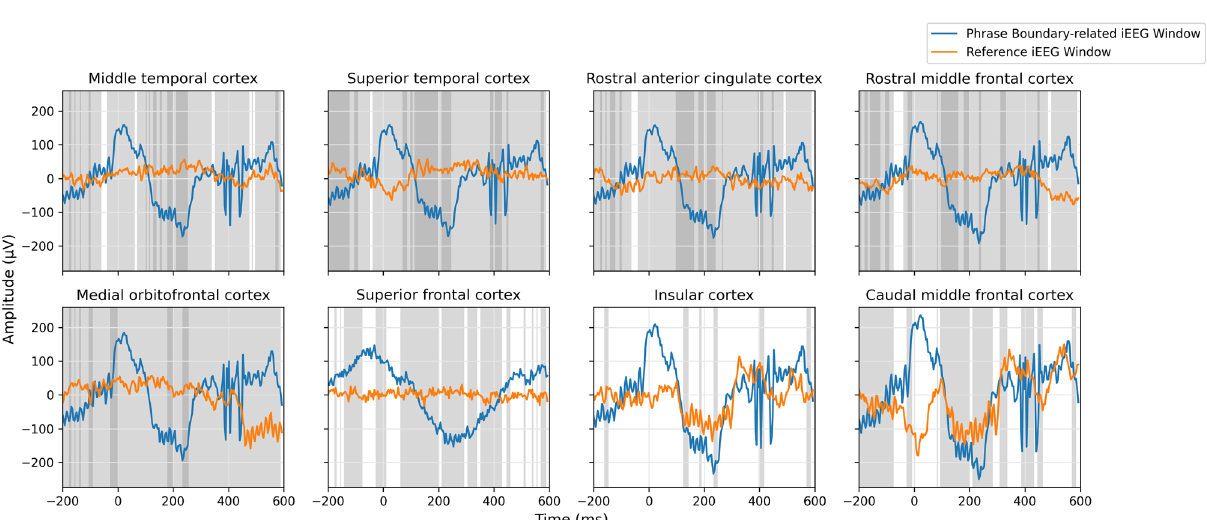
Figure 2. Phrase-boundary-related ERPs observed at these subregions with significance in at least six sessions are shaded in light gray and ten sessions in dark gray